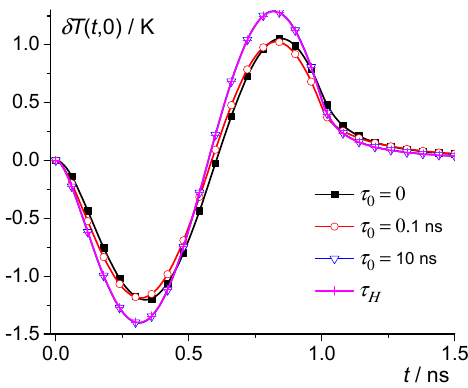
Figure 4. Dependence of the temperature change δ T ( t 0 , r ) on distance r at t 0 = 0.25 ns ( a ) and t 0 = 0.6 ns ( b ) for iPS at ∆ T = 30 K. τ 0 = 0, 0.1 ns, 1 ns, 10 ns, and 100 ns—squares, circles, triangles, stars, and diamonds; crosses are the result of averaging δ T over the distribution H ( τ 0 ) . Thus, the magnitude of the local temperature change 𝛿𝑇 ( 𝑡 , 𝑟 ) during the nucleation in